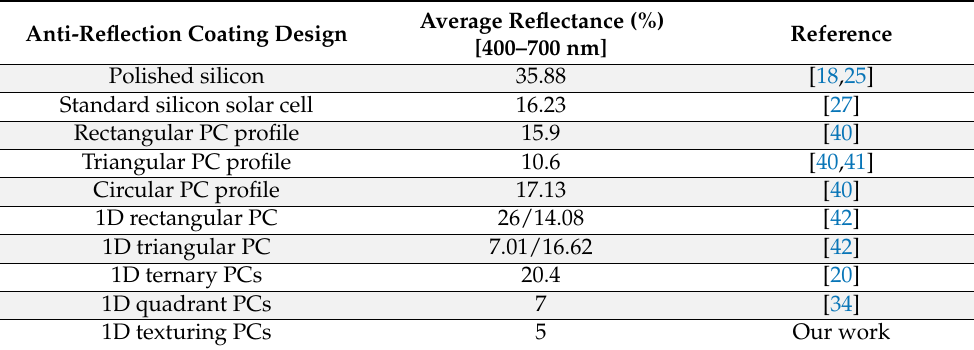
Figure 9. Hydrogenated amorphous silicon solar cell (a-Si: H) absorption spectrum with ternary anti-reflective coating with texturing on the top surface with a height equal to 50 nm at different incident angles. The ternary ARC is composed of silicon nitride with a thickness of 33 nm immersed between silicon dioxide and titanium dioxide with a thickness of 54 nm and 82 nm, respectively. Also, the back reflector is composed of silicon dioxide and silicon, with thicknesses of 40 nm and 75 nm, respectively. The number of periods equals 12. These calculations are determined at the planner surface and texturing surface with a height equal to 25 nm. Table 1. The average reflection of anti-reflection coating designs for noteworthy findings in the literature in comparison to our work.